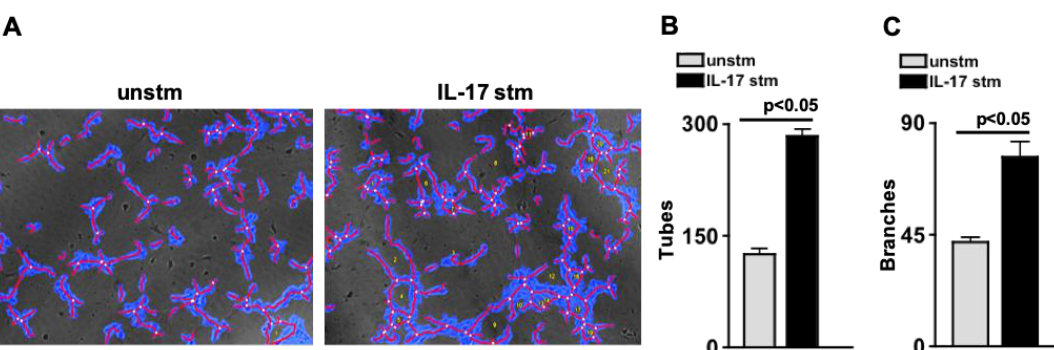
Figure 3 . IL-17A Initiates Retinal Endothelial Cell Proliferation. ( A ) Representative images of WimTube analytical overlay of unstimulated and IL-17A-stimulated human retinal endothelial cells. Quantification of the number of angiogenic tubes ( B ) and branches ( C ) in unstimulated (grey) or IL-17A-stimulated (black) human retinal endothelial cells. Error bars represent the SEM. The p -values were equated using two-way ANOVA and then unpaired Student’s t -test with Tukey’s post-hoc analysis.